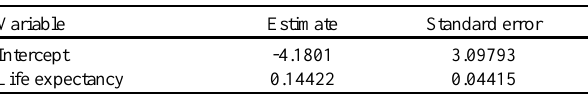
Table 10 . Parameter estimates for variables selected in the best model of social-ecological factors and the proportion of endangered and invasive birds and mammals in 100 different